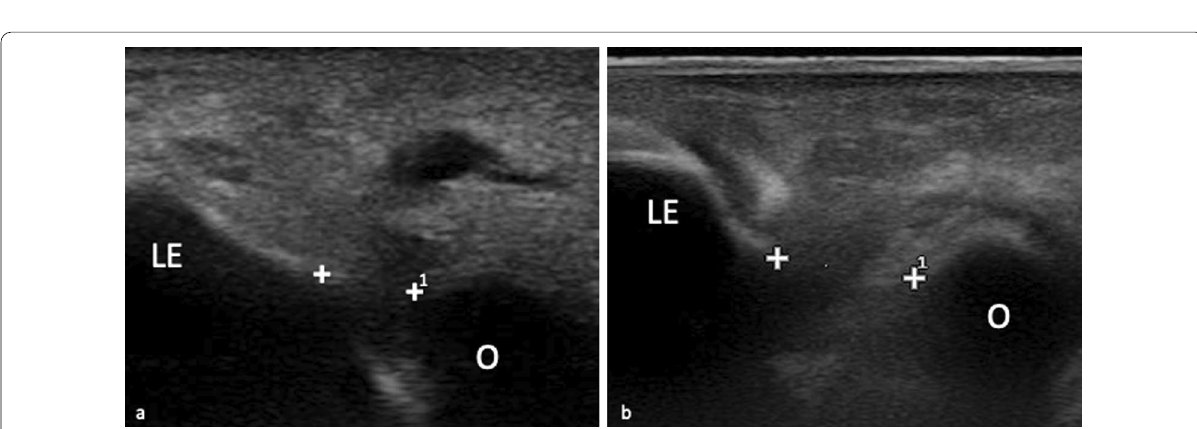
Fig. 10 Posterolateral rotatory instability (PLRI) at dynamic US examination. The probe is placed in an axial approach between the lateral epicondyle (LE) and the olecranon (O), as the humero-ulnar joint is visualized. While applying a posterolateral rotatory stress, widening of the humero-ulnar joint is determined (white calipers): a widening greater than 4 mm, from resting ( a ) to stress ( b ) conditions, is considered indicative of